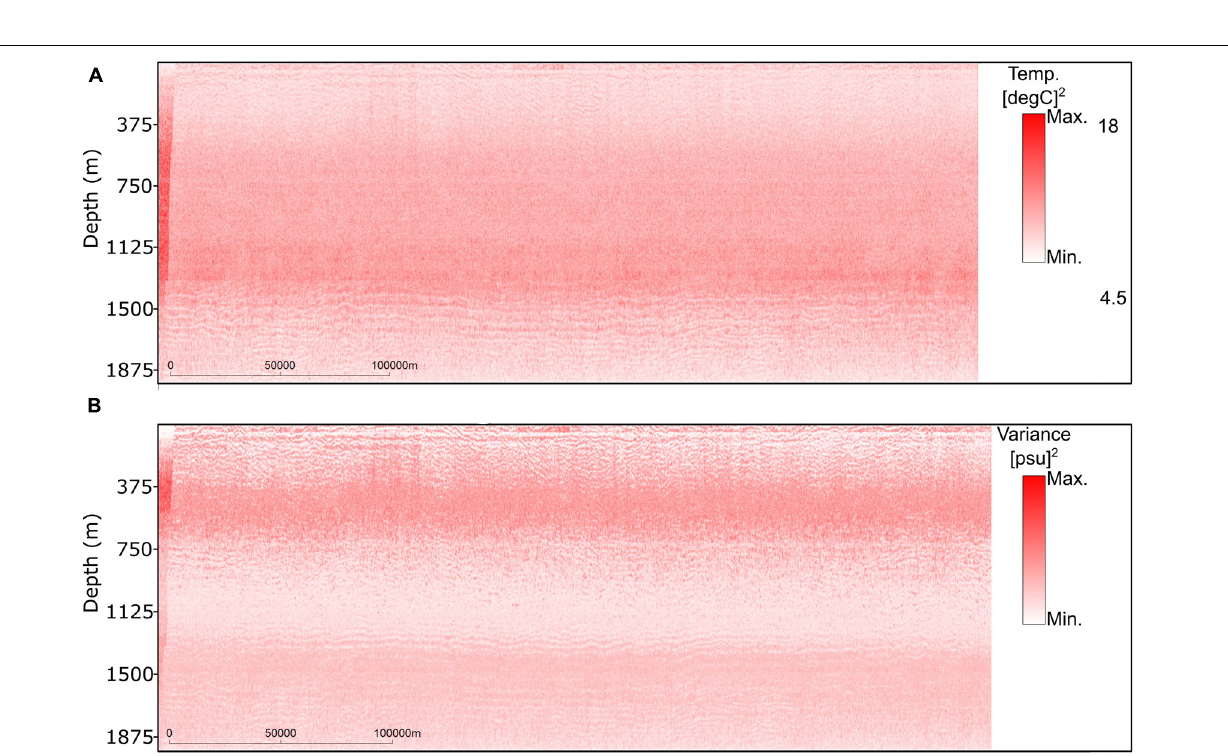
Frontiers in Marine Science |